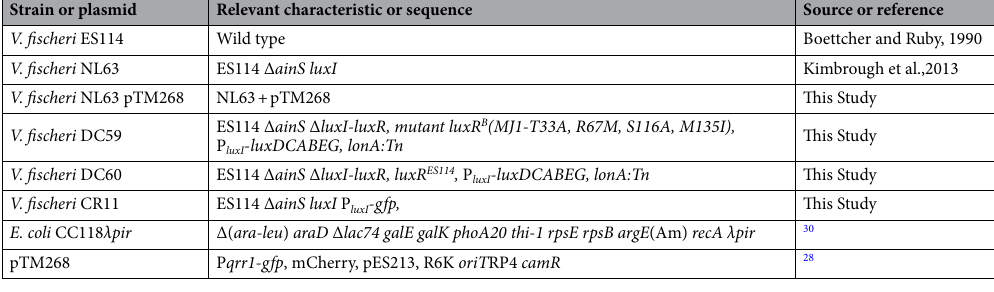
Table 1. Strains used in this